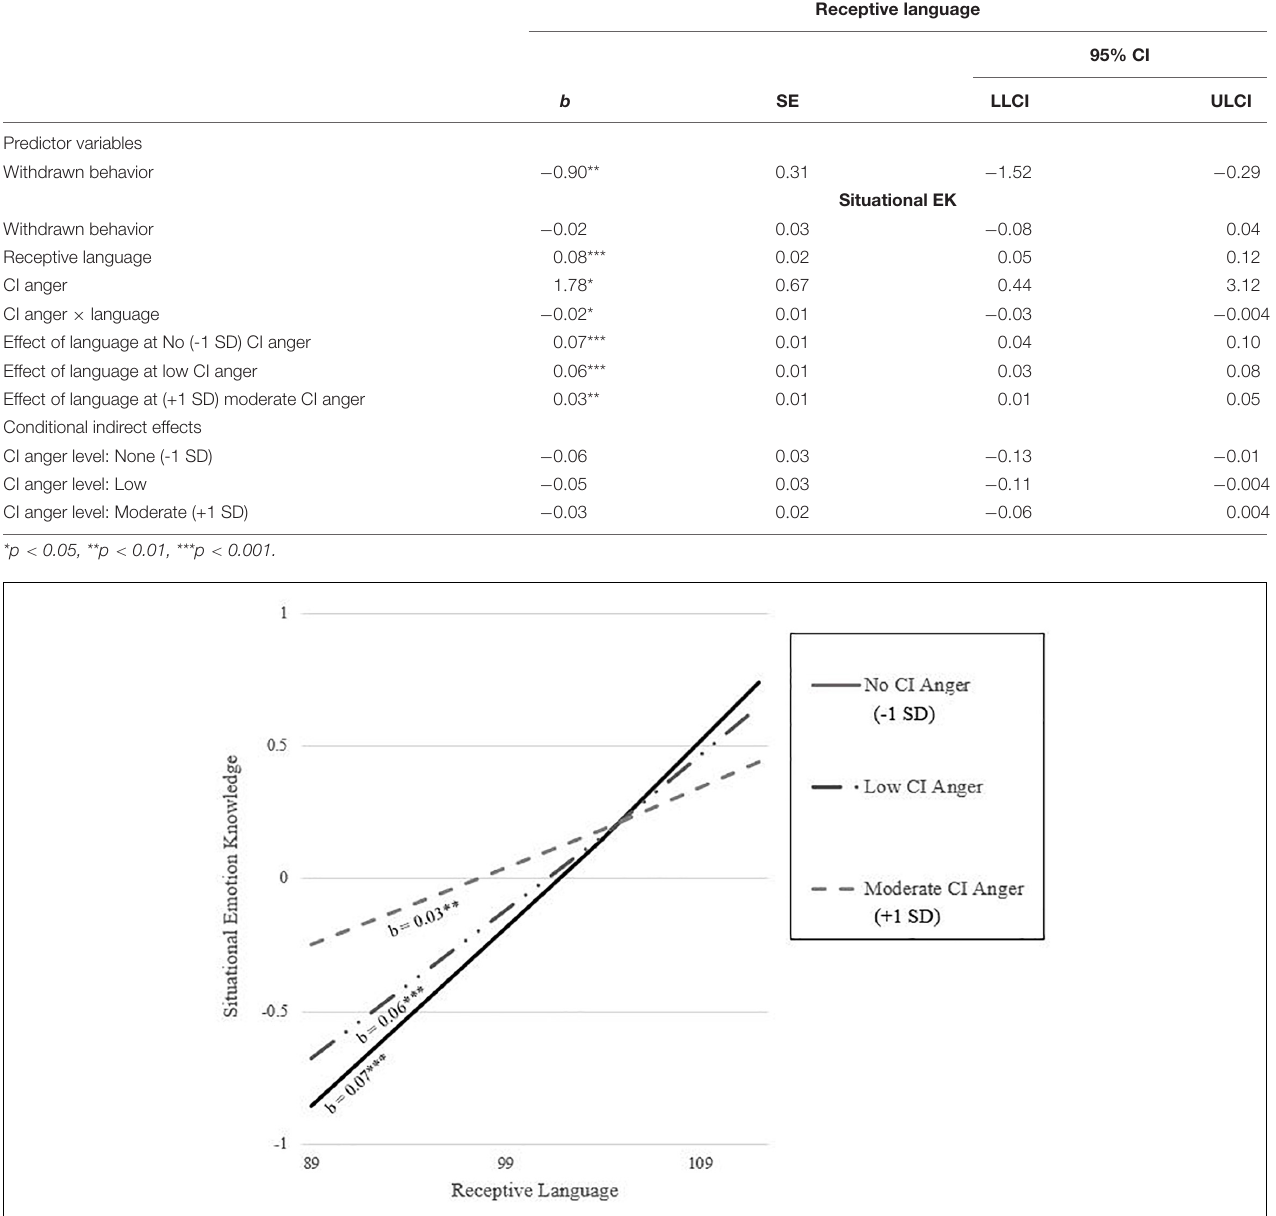
FIGURE 3 | Moderation of association between receptive language and situational emotion knowledge by CI anger. Conditional effects are represented by groupings of the 16th, 50th, and 84th percentile. ∗∗ p < 0.01, ∗∗∗ p <